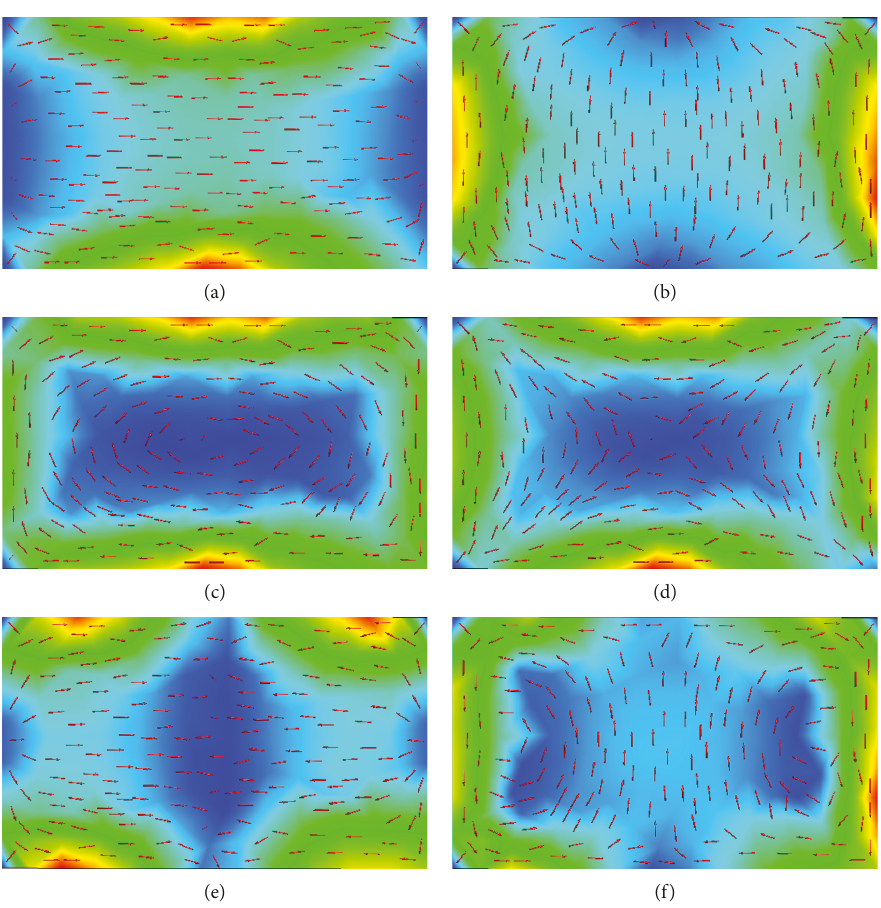
Figure 2: Characteristic currents for the fi rst six modes of the rectangular metal plate at 2.5 GHz: (a) mode 1, (b) mode 2, (c) mode 3, (d) mode 4, (e) mode 5, and (f) mode 6.